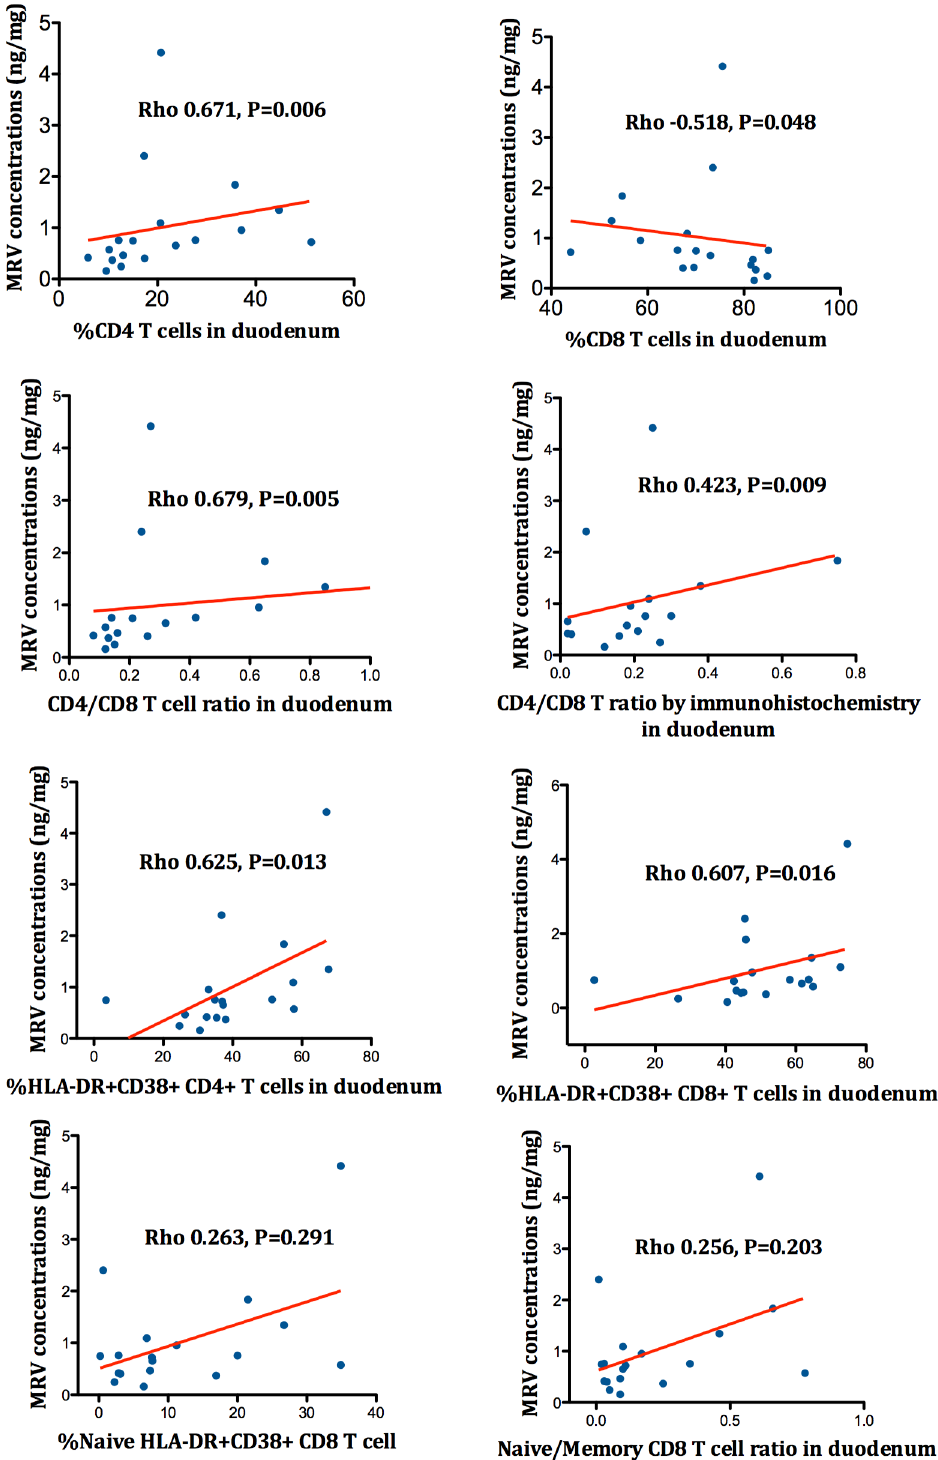
Fig 8. Correlations between MVC duodenal concentrations and several markers of duodenal immunity.